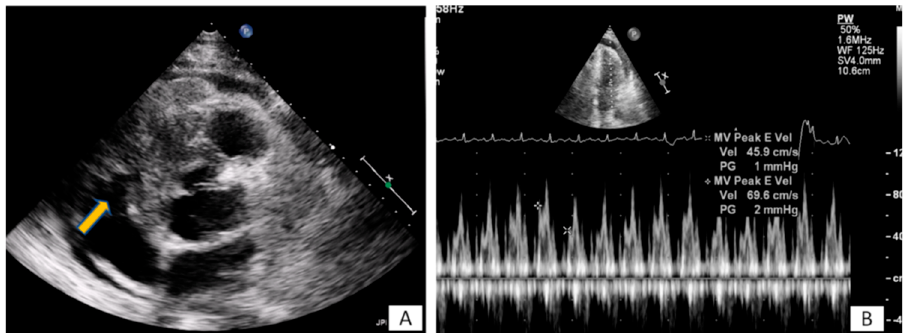
Figure 3. ( A ) A 65-year-old patient with fever and dyspnea for 15 days. Transthoracic echo (modified short axis view) demonstrated an amorphous mass (arrow) infiltrating the tricuspid annulus, right ventricular free wall and pericardium, causing a moderate in size pericardial effusion. ( B ) The pericardial fluid led to tamponade ( B ). Biopsy revealed a lymphoma.